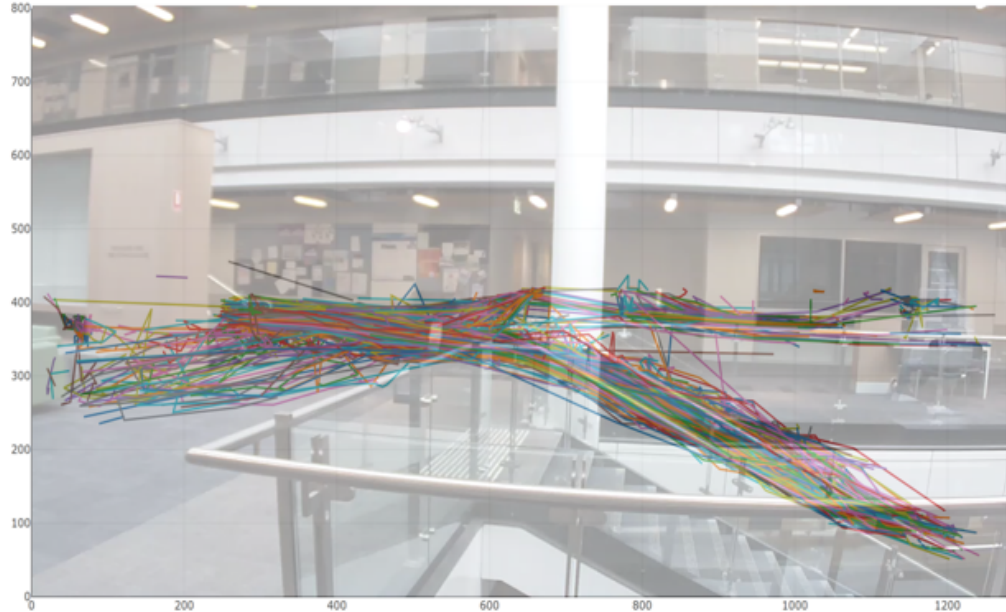
Figure 15. Trajectories followed by the individuals detected and tracked by the sensor. Each of the 631 lines represent one individual.